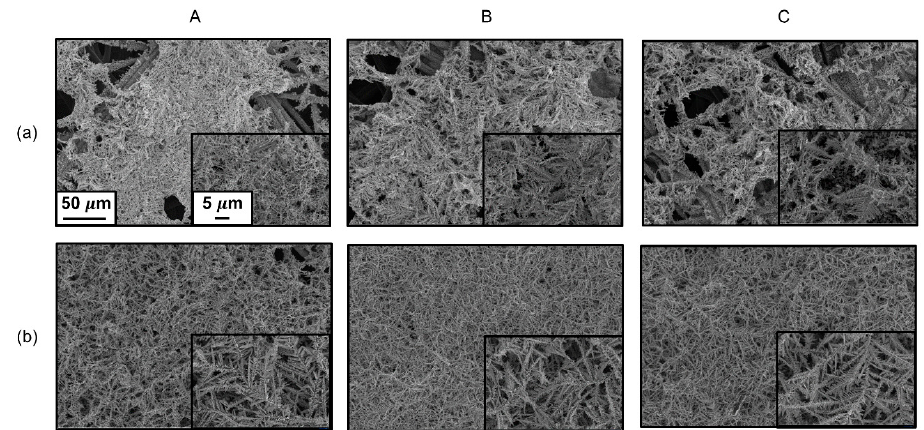
Figure 2. Field emission scanning electron microscope (FE-SEM) images of the fabricated 25.5 cm 2 Ag GDE (Figure 1) according to the position on the electrode: ( a ) three-electrode system; ( b ) two-electrode system.